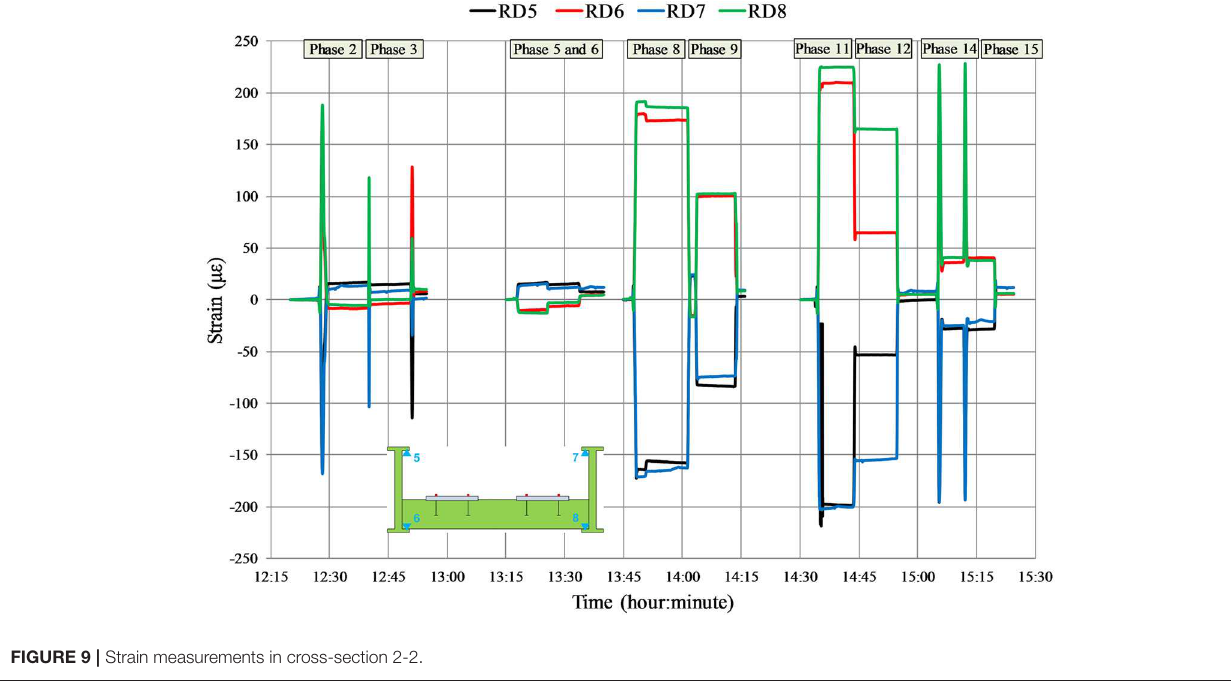
FIGURE 9 | Strain measurements in cross-section 2-2.